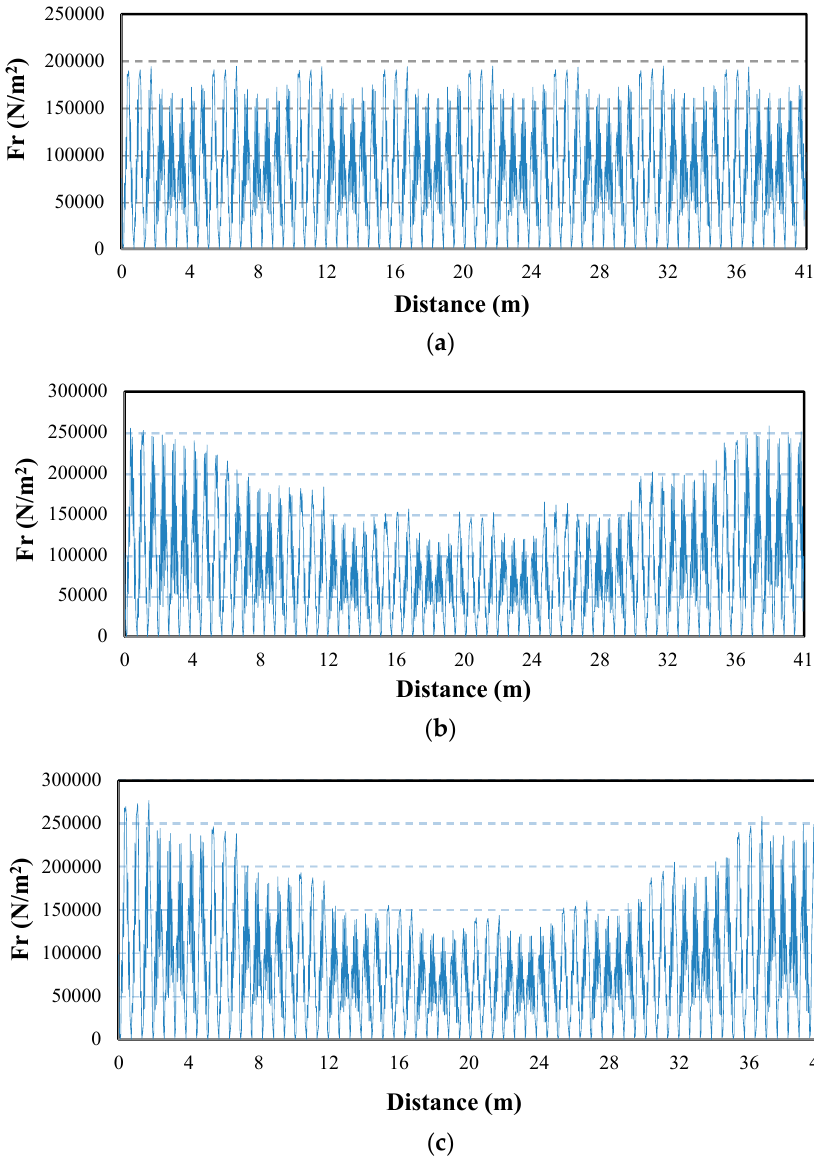
Figure 13. Electromagnetic force densities at the center of air-gap with different eccentricity: ( a ) concentric model; ( b ) static eccentric model; and ( c ) dynamic eccentric model.